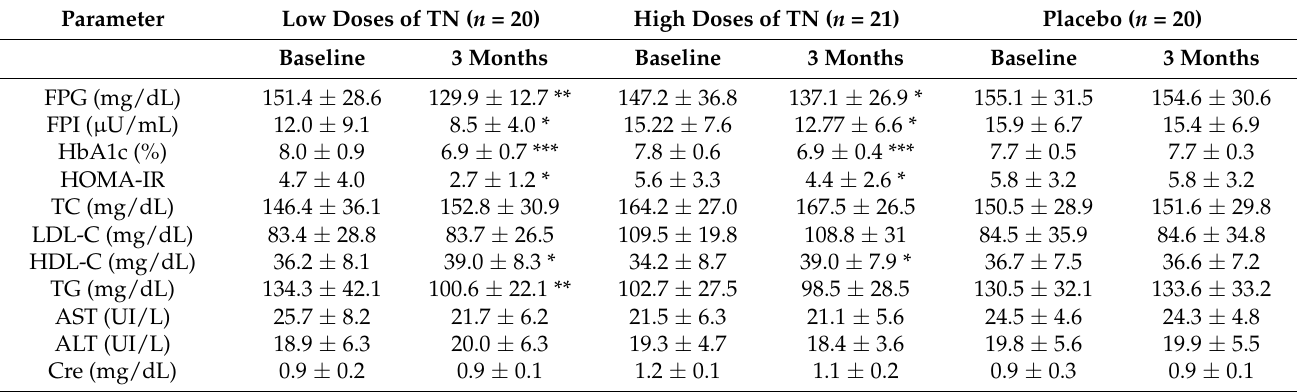
Table 2. Baseline and 3-month biochemical parameters of patients in the placebo, high-dose and low-dose of thinned nectarine